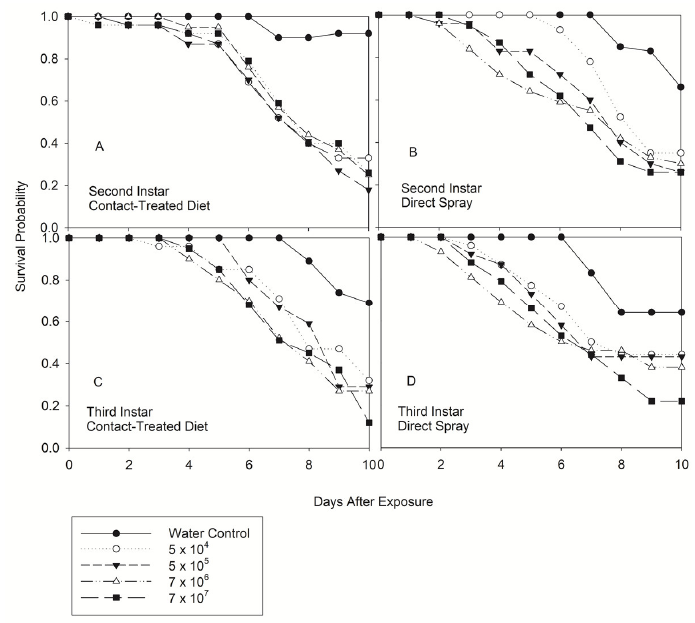
Figure 1. Product-limit survival estimates for 2nd and 3rd instar of Nezara viridula exposed by contact (treated diet) ( A , C ) and direct spray ( B , D ) to Beauveria bassiana , Delta native NI8 strain at different concentration. Insects were fed on an artificial diet ( p = 0.05, LIFETEST of Equality over Strata).